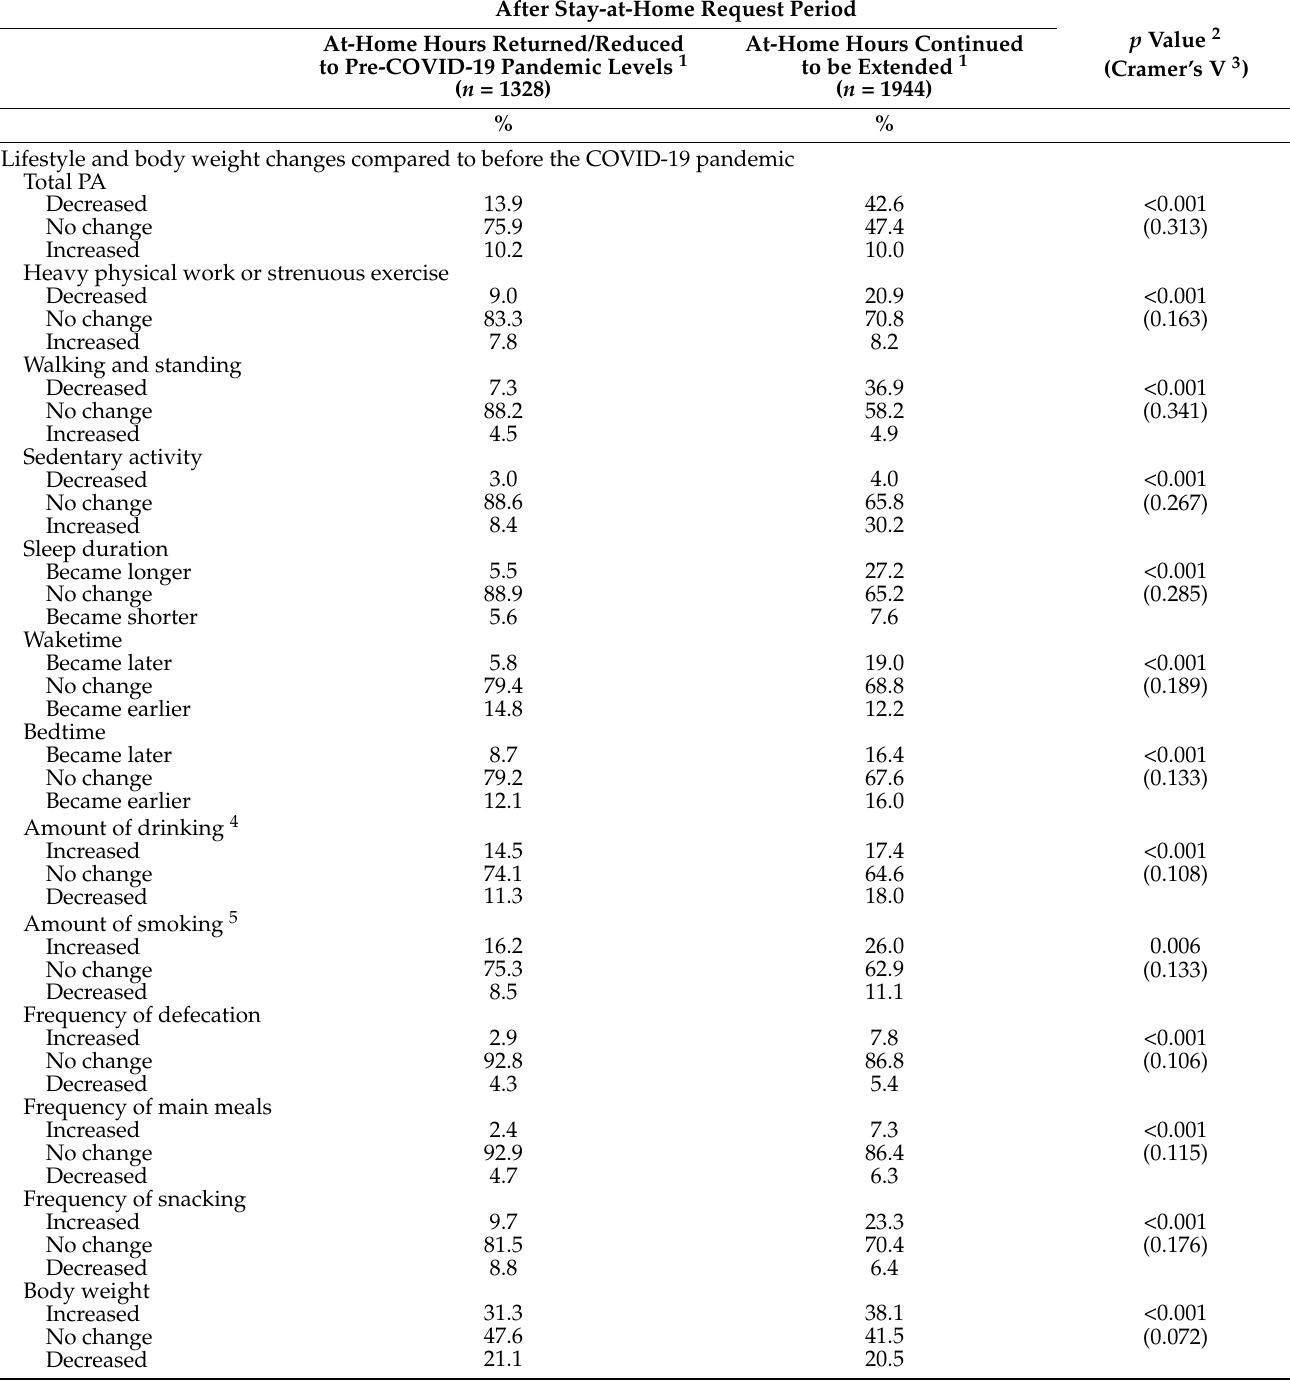
Table 6. Changes in at-home hours after stay-at-home request period among people with extended at-home hours during stay-at-home request period ( n = 3272), and lifestyle and body weight changes after stay-at-home request